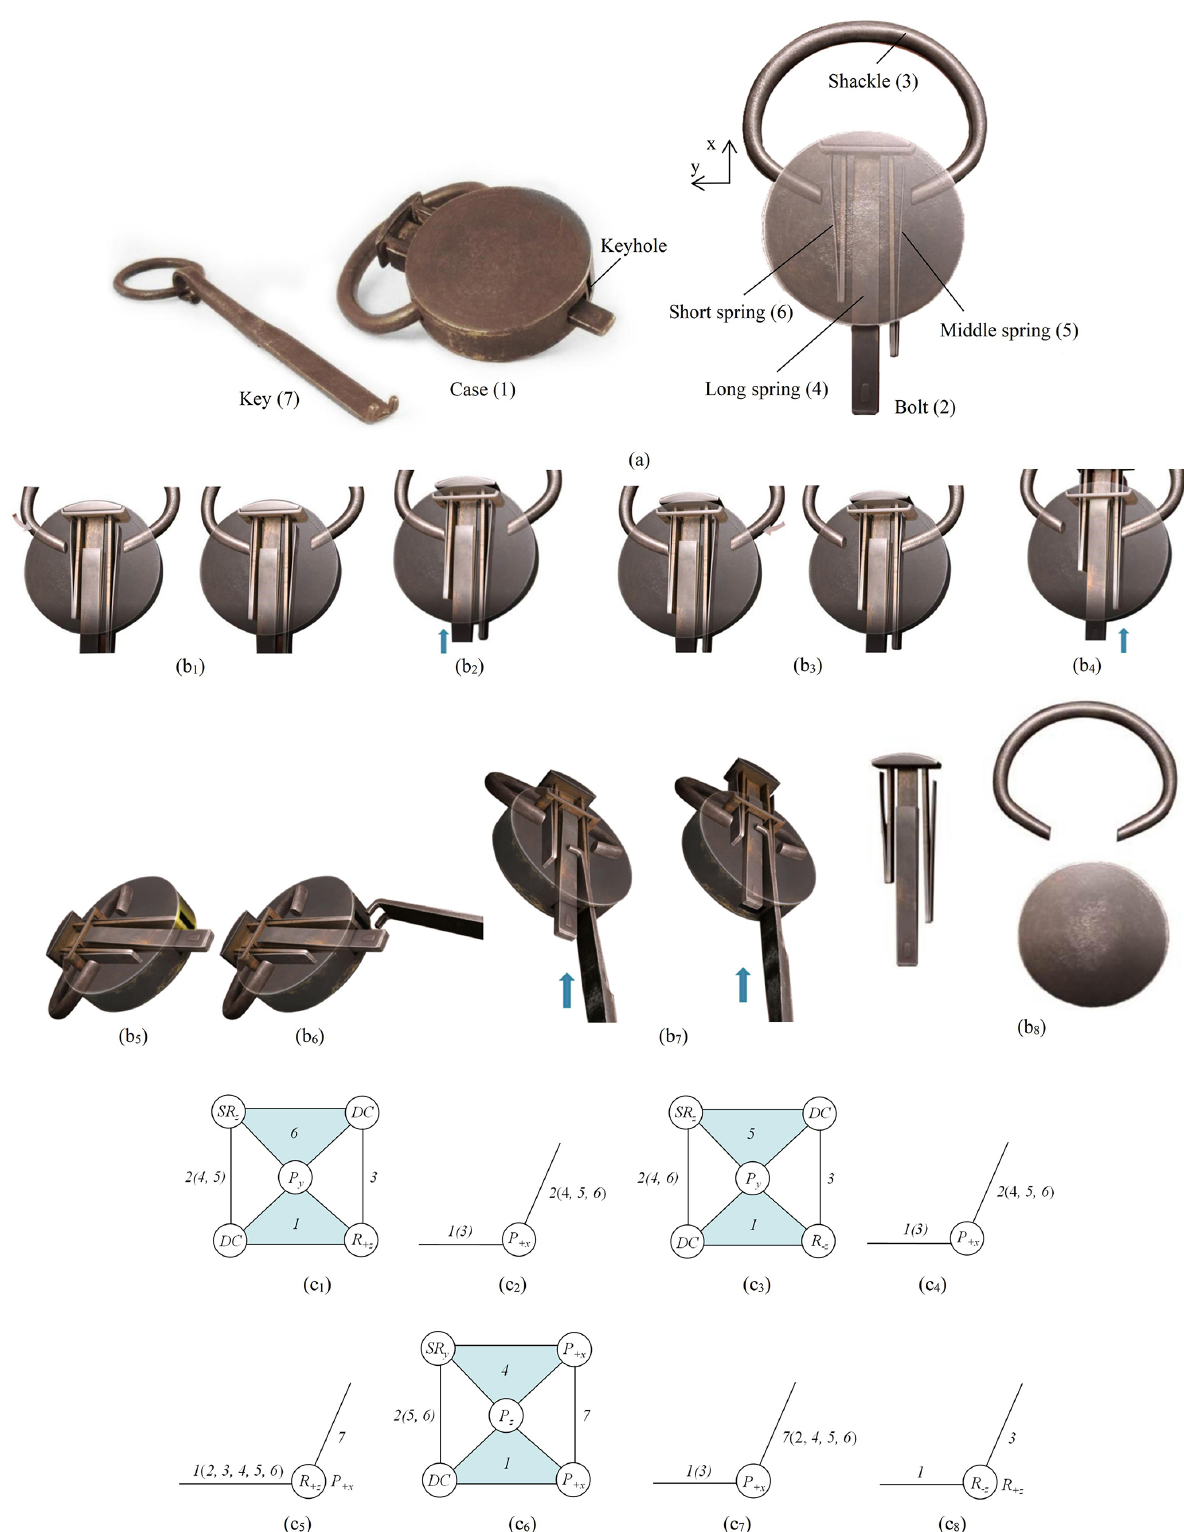
Figure 8. Iron padlock with pressing shackle – with three springs (Yi Zhi Tang Collection).